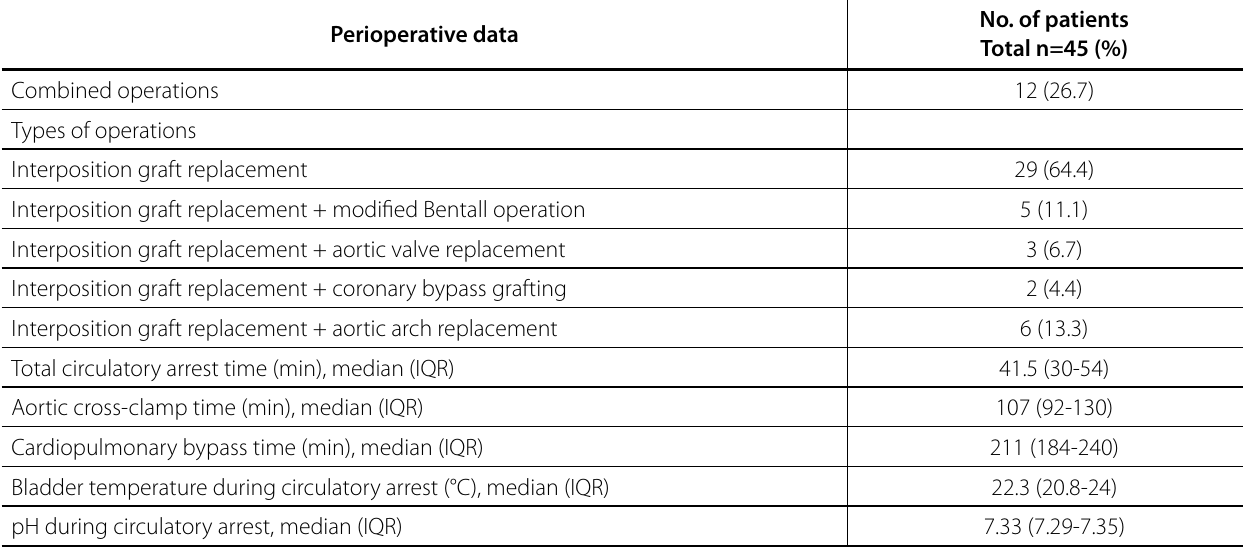
Table 2 . Perioperative